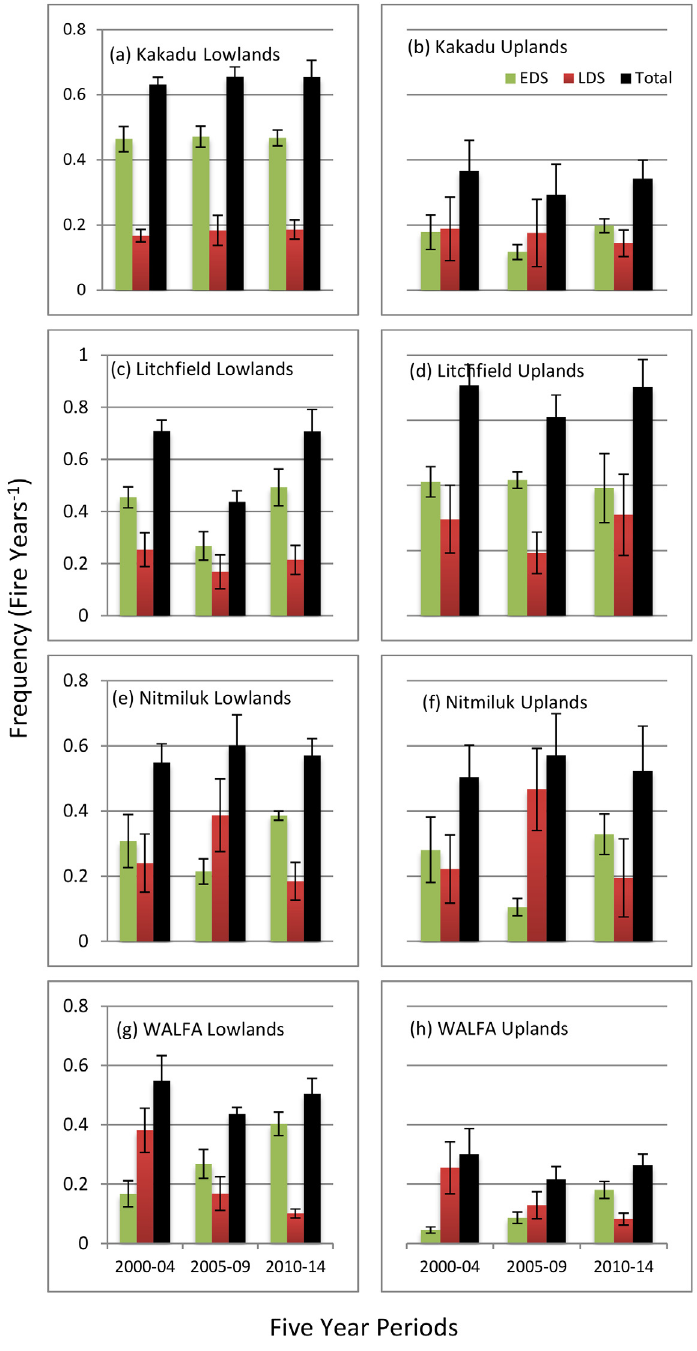
Fig 2. Mean frequency ( ± S.E.M.) of early dry season (EDS — pre-August), late dry season (LDS — post- July), and total (annual) fires in three successive five-year periods (commencing 2000), for the four study sites and respective lowland and upland savanna